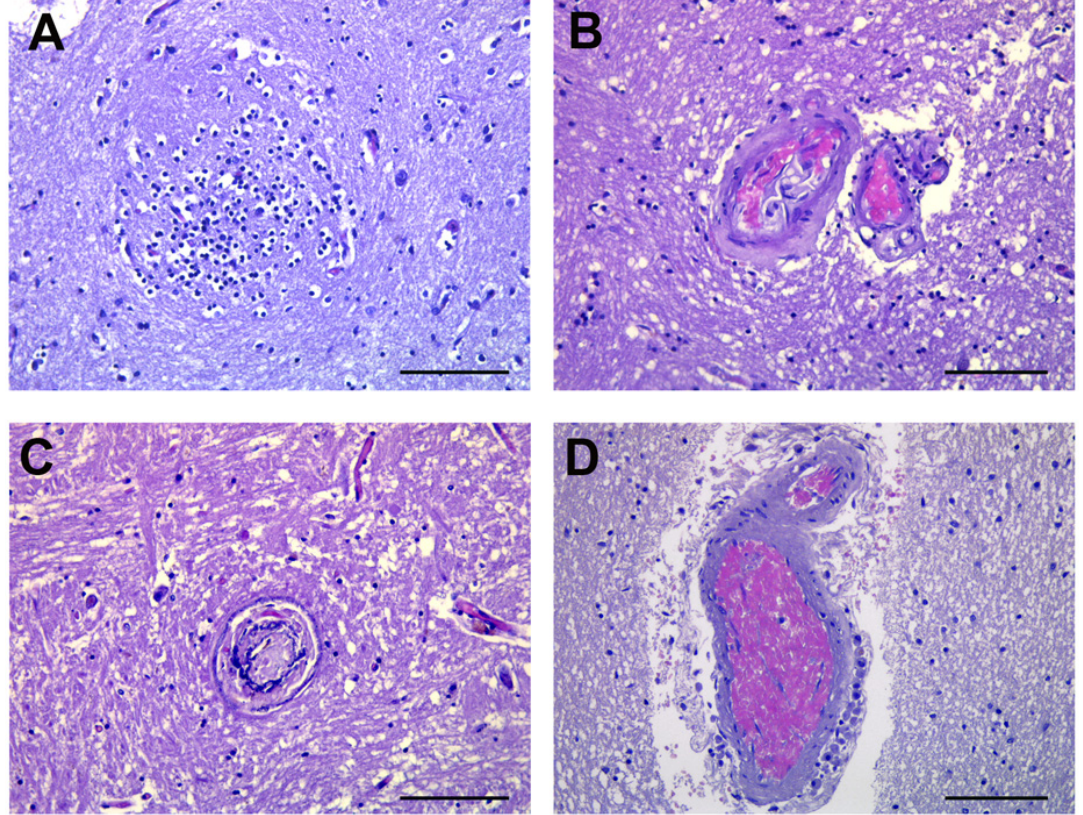
Figure 5. Pathologic reaction of glia and vascular changes. ( A ) Clusters of microglia (microglial nodules) mark the site of the destroyed neurons (arrows), and is the hallmark of neuronophagia. ( B – D ) Microangiopathy in most of the small vessels. Deposits of eosinophilic hyaline material with a “lumen within a lumen” appearance, siderocalcinosis and ferruginazation of microvessels and fibrosis are visible. Images from patients who did not have previous neurological deficits. Scale bars: ( A – D ) = 50 μ m.